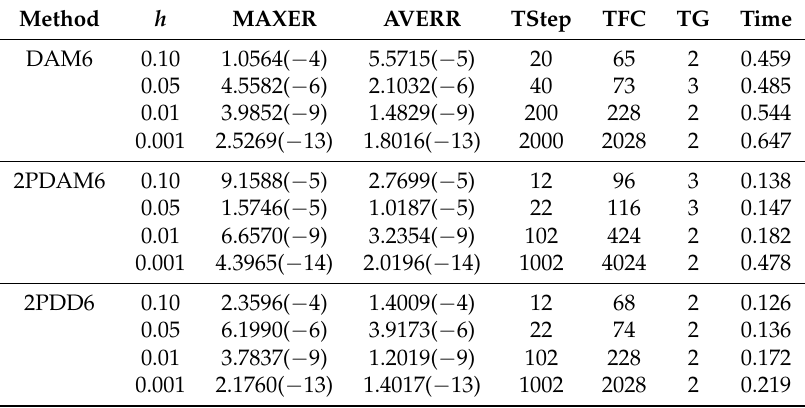
Table 1. Results for solving Test Problem